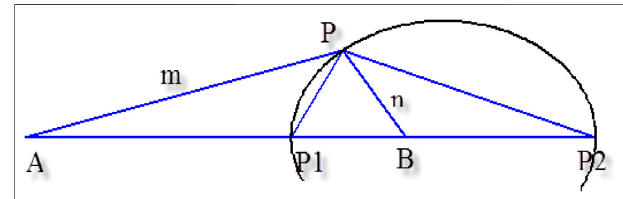
FIGURE 2 | The interior bisector PP1 and the exterior bisector is